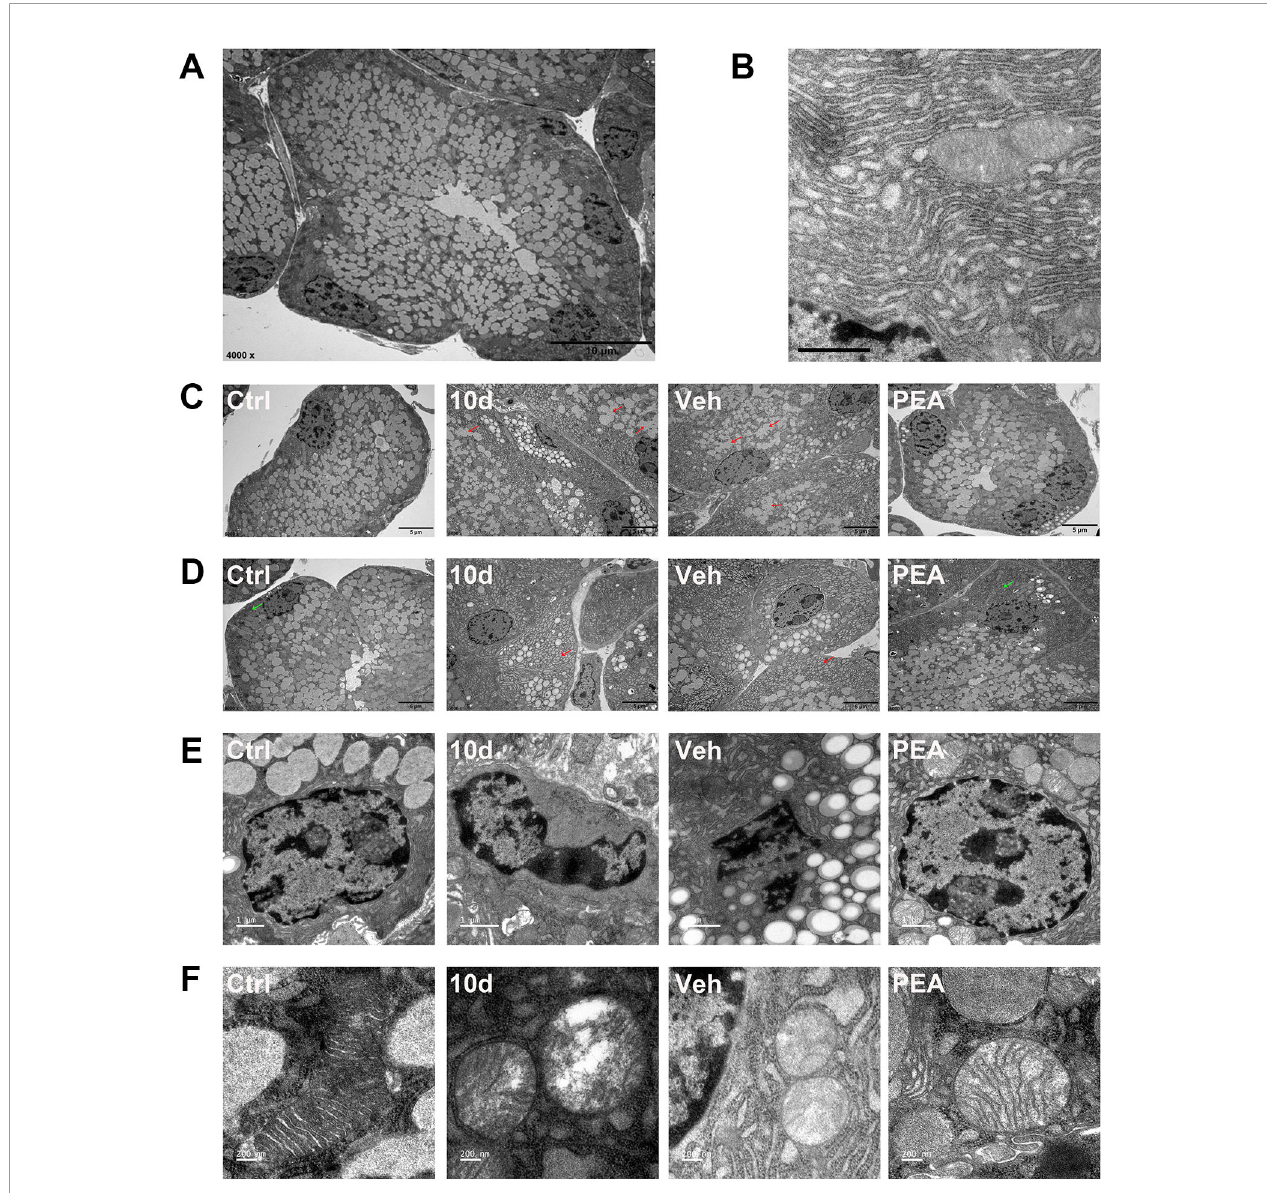
FIGURE 6 | PEA normalized the ultrastructural features of LG. Representative transmission electron micrographs of normal acinar cell ( A scale bars: 10 m m) and endoplasmic reticulum (ER, B , scale bars: 1 m m). SD induced secretory granules fusion ( C , red arrows, scale bars: 5 m m), dilated cisternae of the ER ( D , red arrows, scale bars: 5 m m), nuclear pyknosis ( E , scale bars: 1 m m), and swollen mitochondria ( F , scale bars: 200 nm) in LG acinar cell. PEA treatment restored the normal morphology secretory granules, ER ( D , green arrows), nuclear and mitochondria. n =